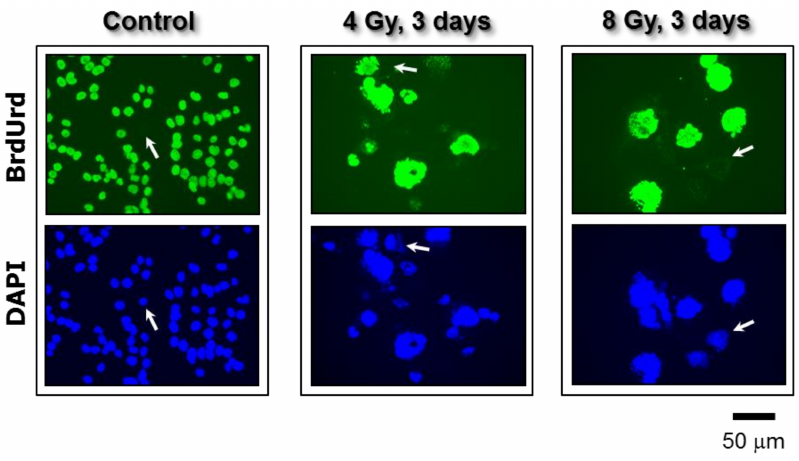
Figure 6. Fluorescence images showing proliferating cells (BrdUrd-positive; green) and total cells (DAPI; blue) in cultures of the p53 knock out HCT116 colon carcinoma cell line. Images were acquired before and three days after exposure to ionizing radiation. In all of the experiments, BrdUrd was added to the culture medium for the final 24 h of the incubation period to allow for its incorporation into genomic DNA. Arrows show some cells that did not incorporate BrdUrd under these conditions. All images were acquired at the same magnification. Taken from Mirzayans et al.